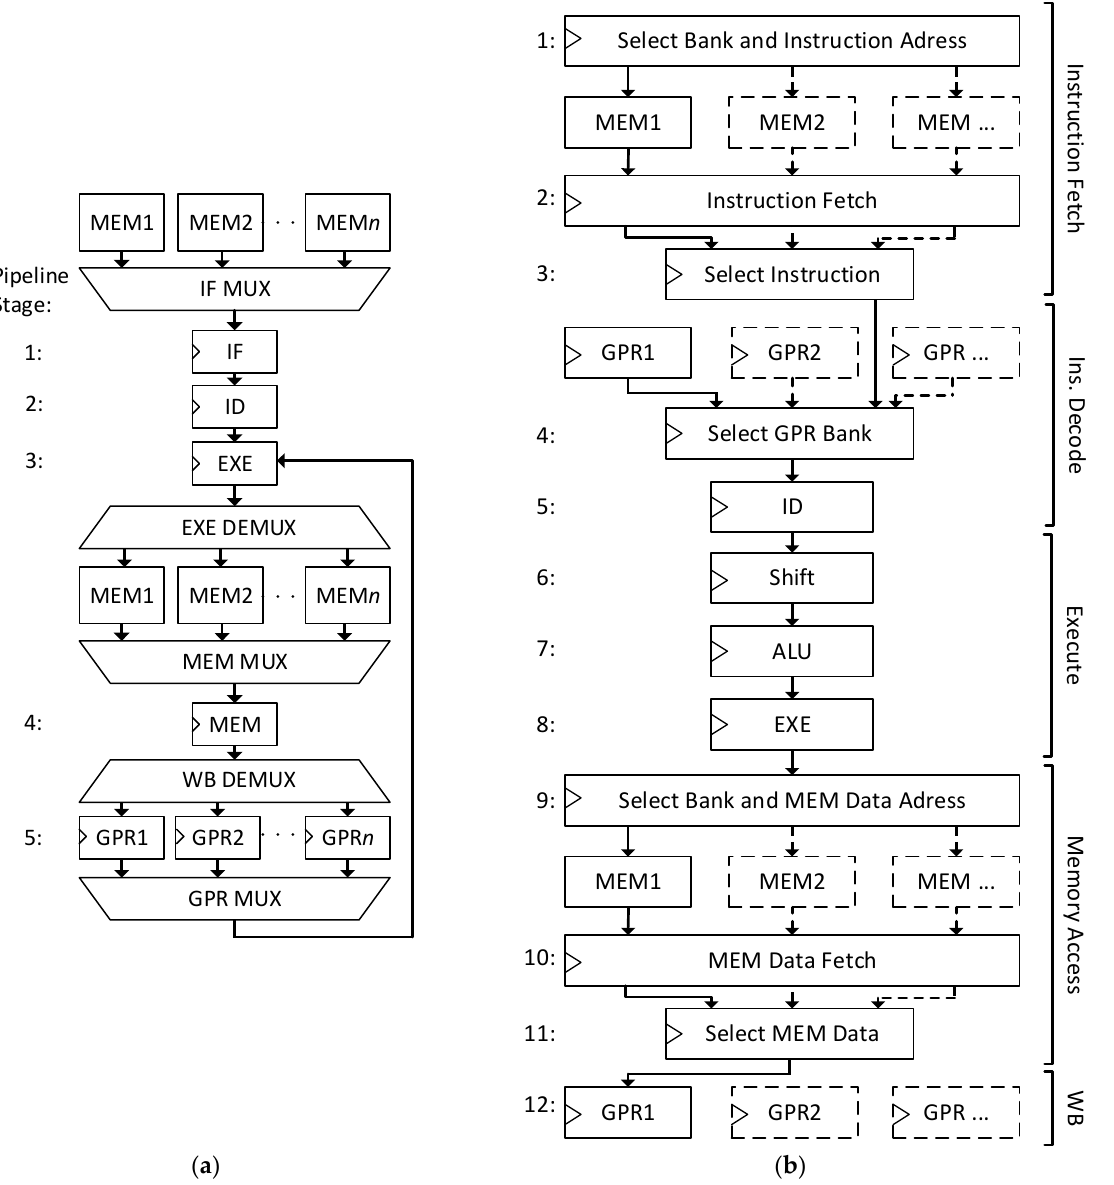
Figure 6. Basic 5-staged pipeline ( a ) and the most advanced 12-staged pipeline ( b ) of the multithread processor.